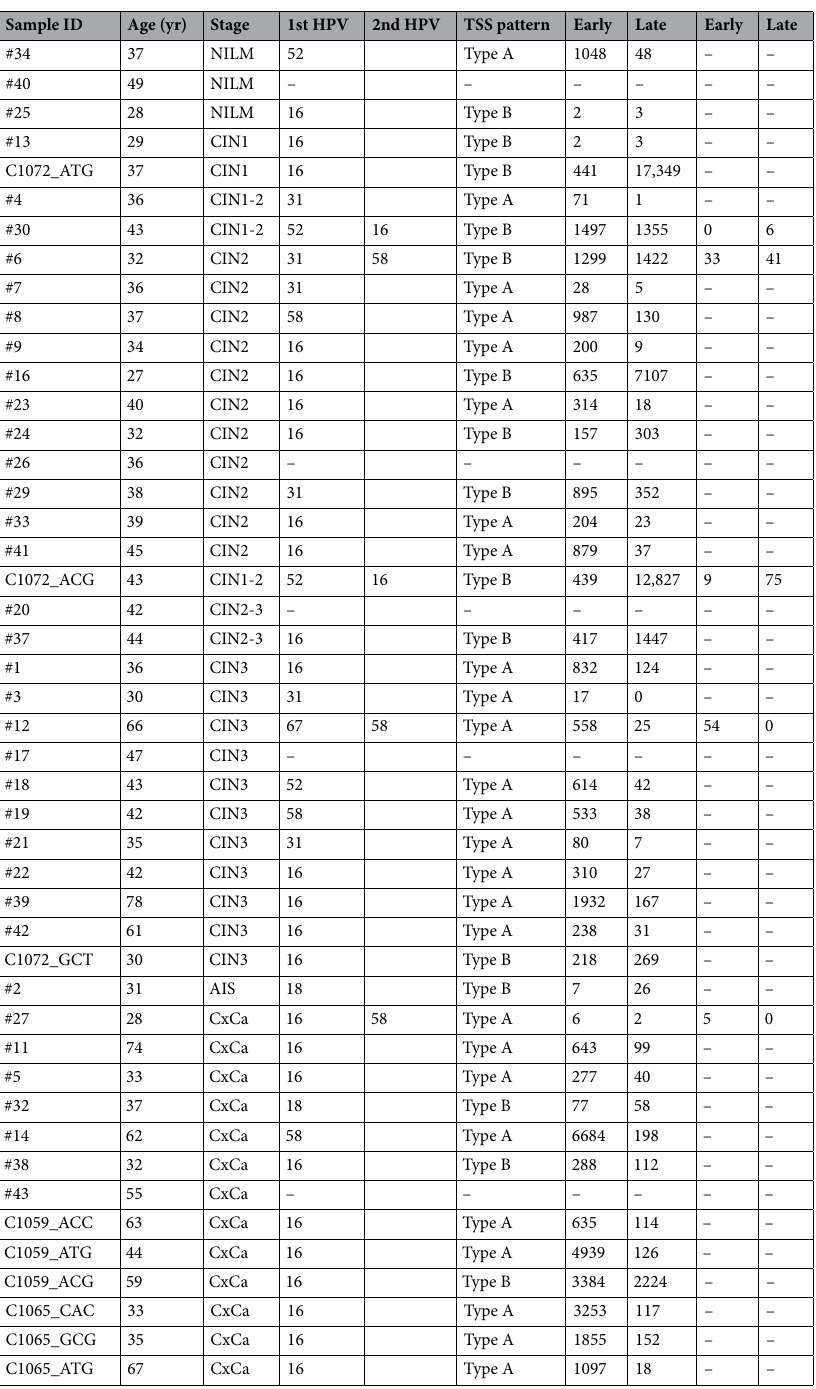
Table 1. Summary of clinical information for patients with cervical lesions. Forty-six cervical lesions, from normal and cancerous lesions, were analyzed by nAnTi-CAGE or nanoCAGE (9 for nAnTi-CAGE and 37 for nanoCAGE). The HPV TSS patterns were classified into broad TSS types: the early promoter-activated pattern and the late promoter-activated pattern, which were designated Type A and Type B, respectively. We defined broad windows containing the early and late promoters in any HPV genome: from nucleotide 80 to 110, and from nucleotide 600 to 950, respectively. TSS patterns were defined as follows: Type A, one-third of early promoter activity ≥ late promoter activity: and Type B, one-third of early promoter activity < late promoter activity. AIS adenocarcinoma in situ; CIN cervical intraepithelial neoplasia; CxCa cervical cancer; NILM negative for intraepithelial lesion malignancy; TSS transcription start